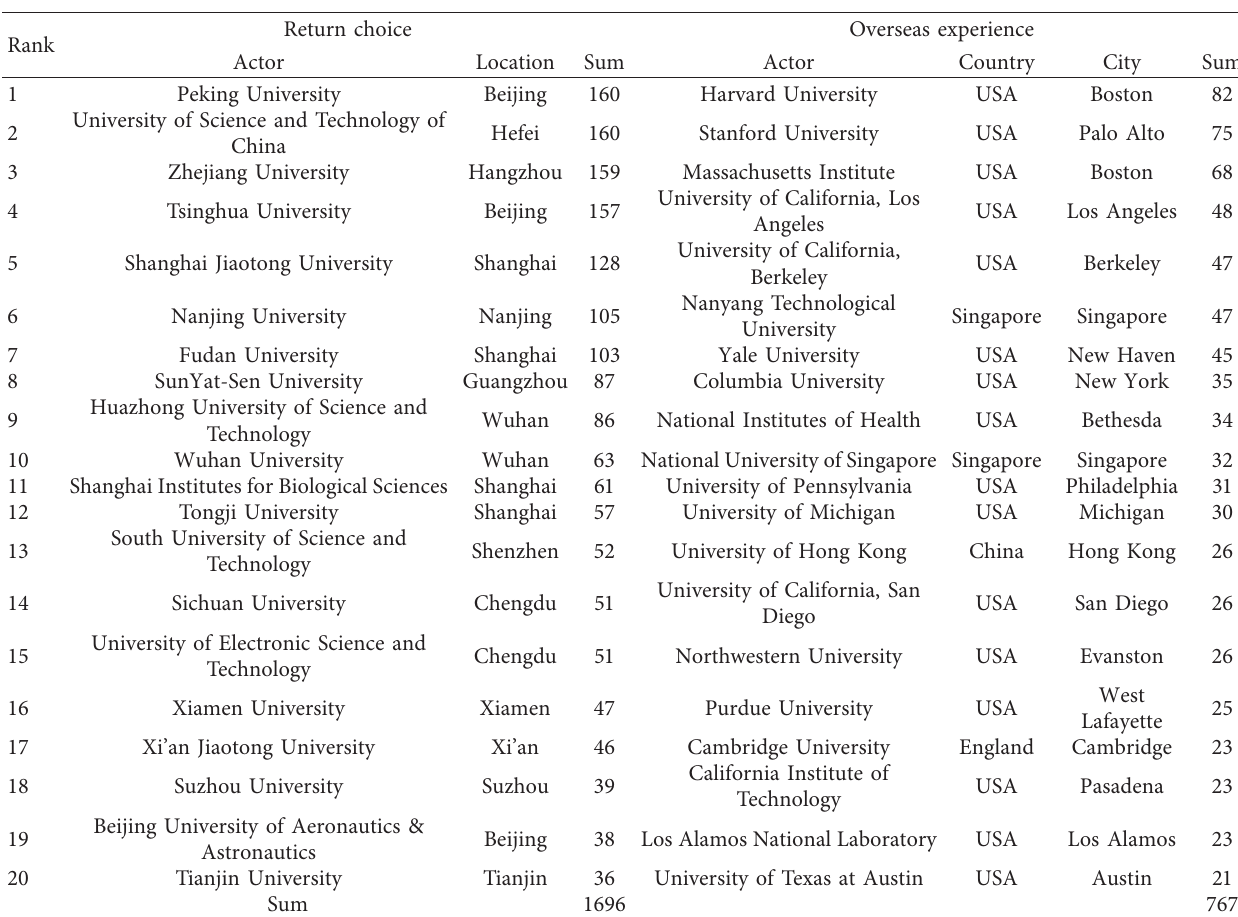
Table 3: Spatial structure of top 20 important actors and overseas organizations.